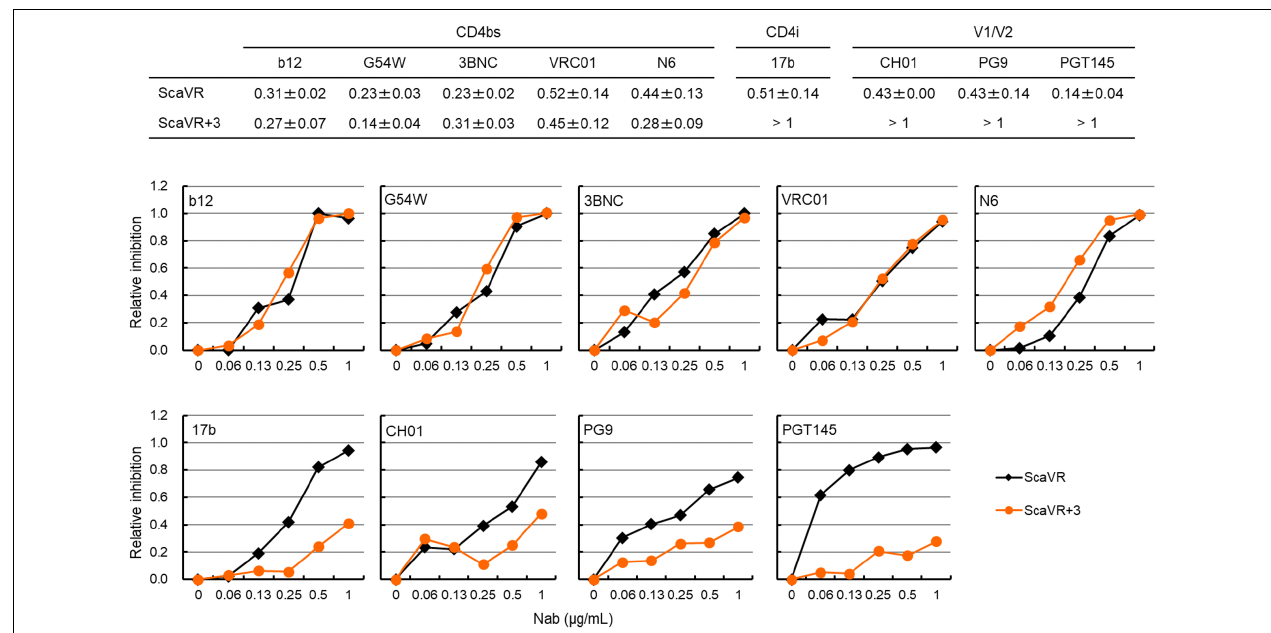
FIGURE 5 | Neutralization sensitivity assays for ScaVR and ScaVR+138/275/427 (ScaVR+3). Viruses were prepared from 293T cells transfected with indicated proviral clones. Virus samples were pre-incubated with each NAb at 37 ◦ C for 1 h, and were inoculated into TZM-bl cells. On day 2 post-infection, cells were lysed for luciferase assays. Relative infectivities were calculated by RLU values with indicated concentrations of NAb relative to that without NAb, and then relative inhibition rates (1.0 minus relative infectivity) were determined and are presented. IC 50 values are indicated in the upper panel. Mean values ± SE are shown ( n = 6 or more). Representative graph data of neutralization sensitivity assays using NAbs are shown. b12, IgG1 b12; G54W, NIH45-46 G54W; 3BNC, 3BNC117; CH01, CH01